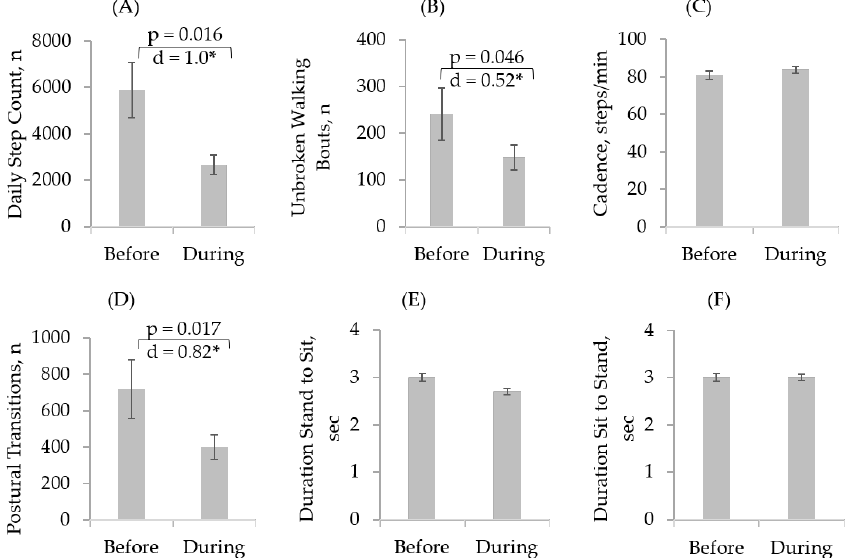
Figure 4. Walking characteristics and postural transitions of the participants as remotely assessed by the PamSys sensor before and during pandemic. We observed a significant decrease in ( A ) daily step count, ( B ) unbroken walking bout, and ( D ) postural transitions. There was no significant change on ( C ) cadence, ( E ) duration of stand to sit transition, and ( F ) duration of sit to stand transition. Error bars indicate standard errors of the corresponding averages (* represents signifi- cant differences ( p < 0.0.05)).